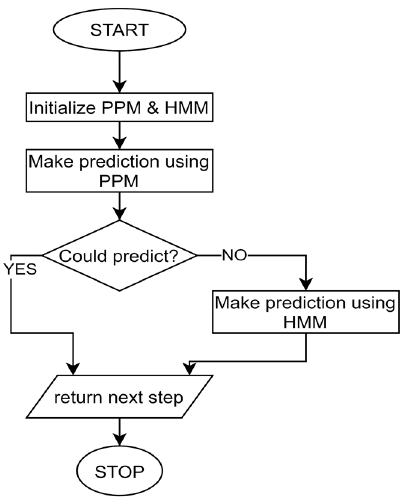
Figure 7. Hybrid predictor with prioritization.